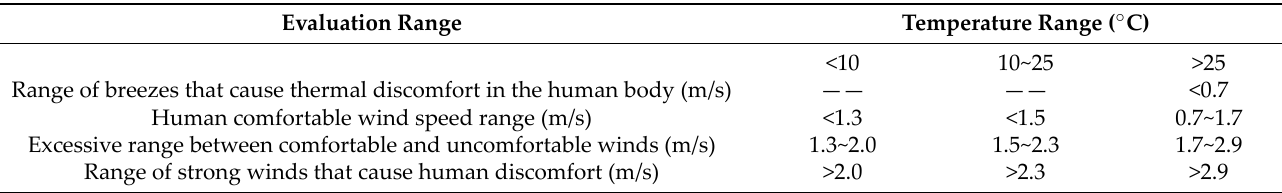
Table 1. Evaluation principle of velocity considering temperature influence.